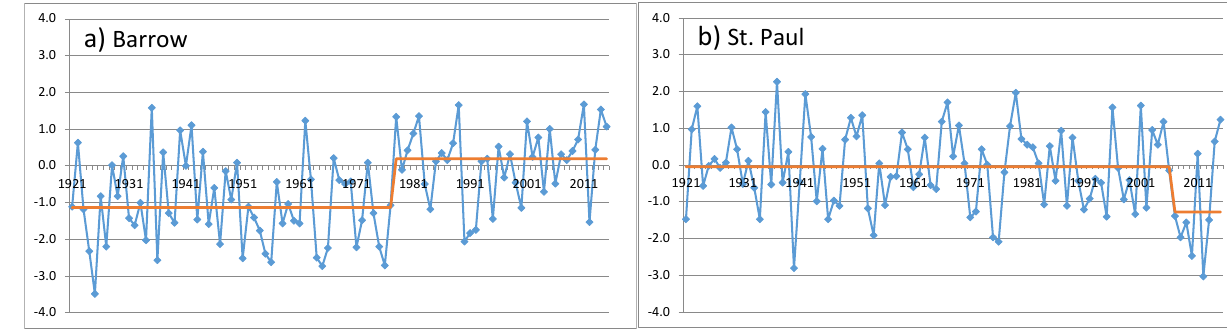
Figure 5. Regime shifts in the mean winter (DJFM) surface air temperatures (SATs) at ( a ) Barrow and ( b ) St. Paul, 1921–2015. The detection was performed using the target significance level 𝑝 = 0.1 and cut-off length 𝑙 = 15. The autocorrelation